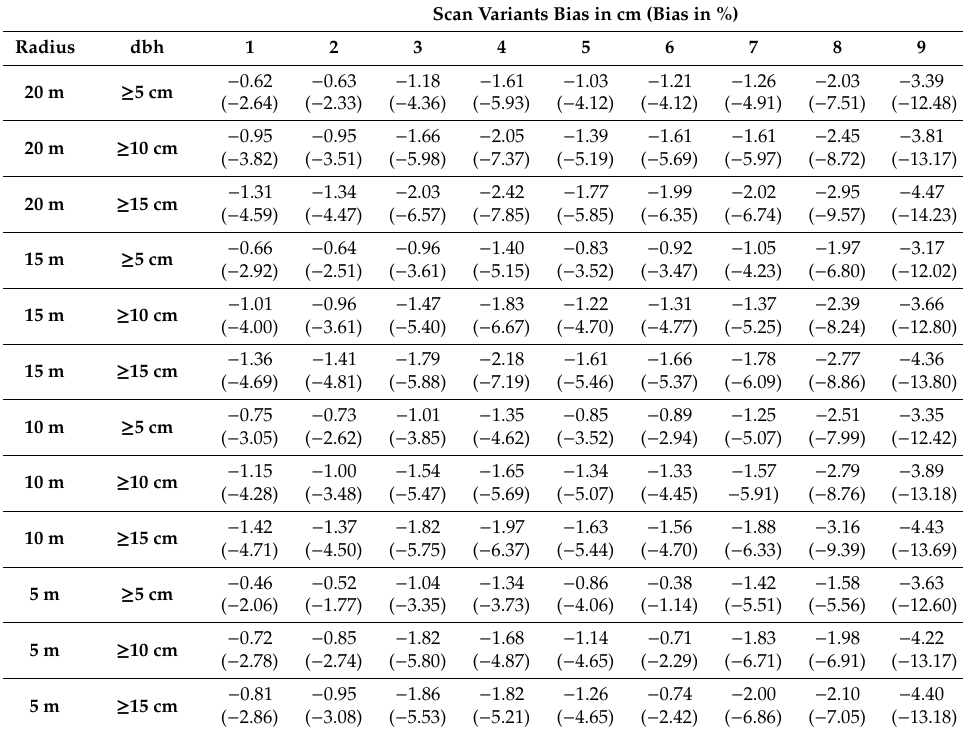
Table 4. Average bias of automatic dbh measurements over all 23 sample plots and depending on scan variant, lower dbh threshold, and plot